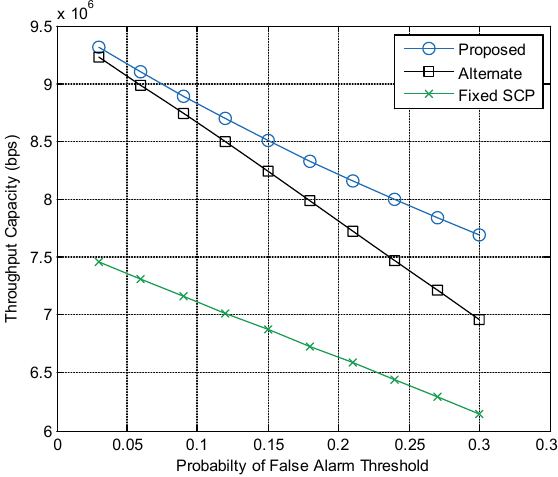
Figure 6. Throughput capacity of the CRN versus probability of false alarm threshold by several schemes.